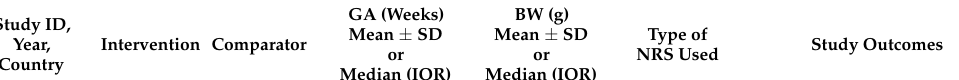
Table 1. Characteristics of the included